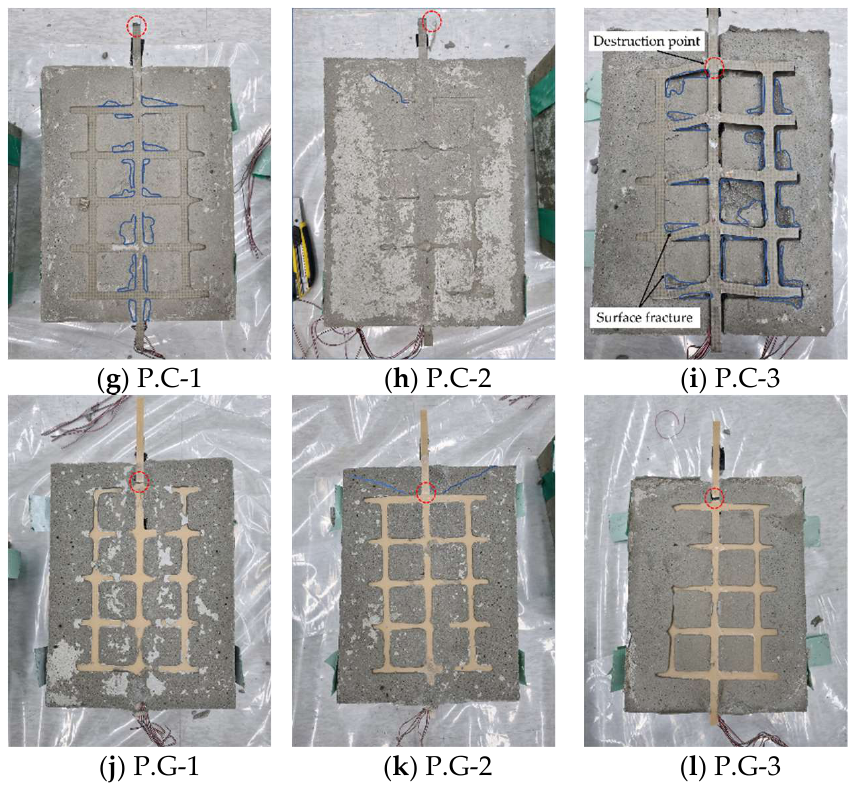
Figure 8. Surface fracture of specimens of CFRP/GFRP grid reinforced concrete.